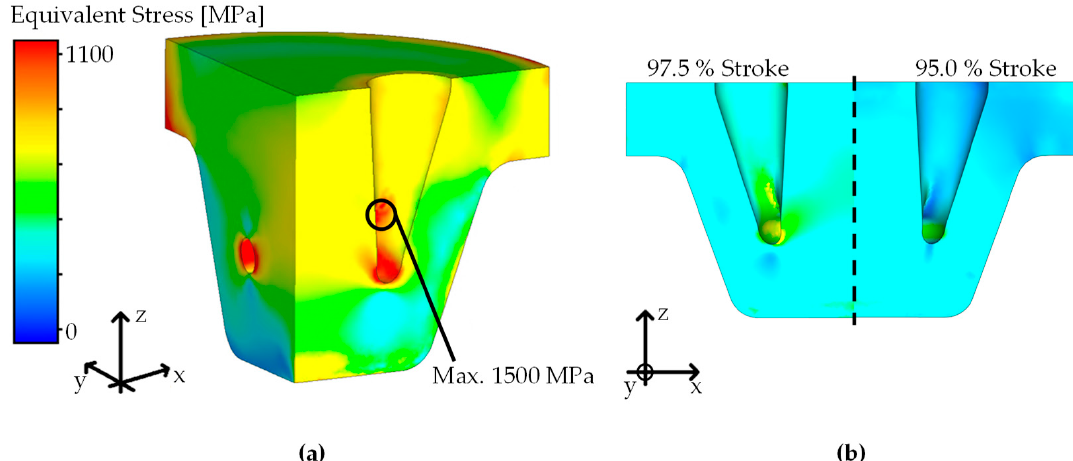
Figure 10. Equivalent stress at 100.0% stroke ( a ), at 97.5% stroke ( b ) and 95.0% stroke for Variant 10.